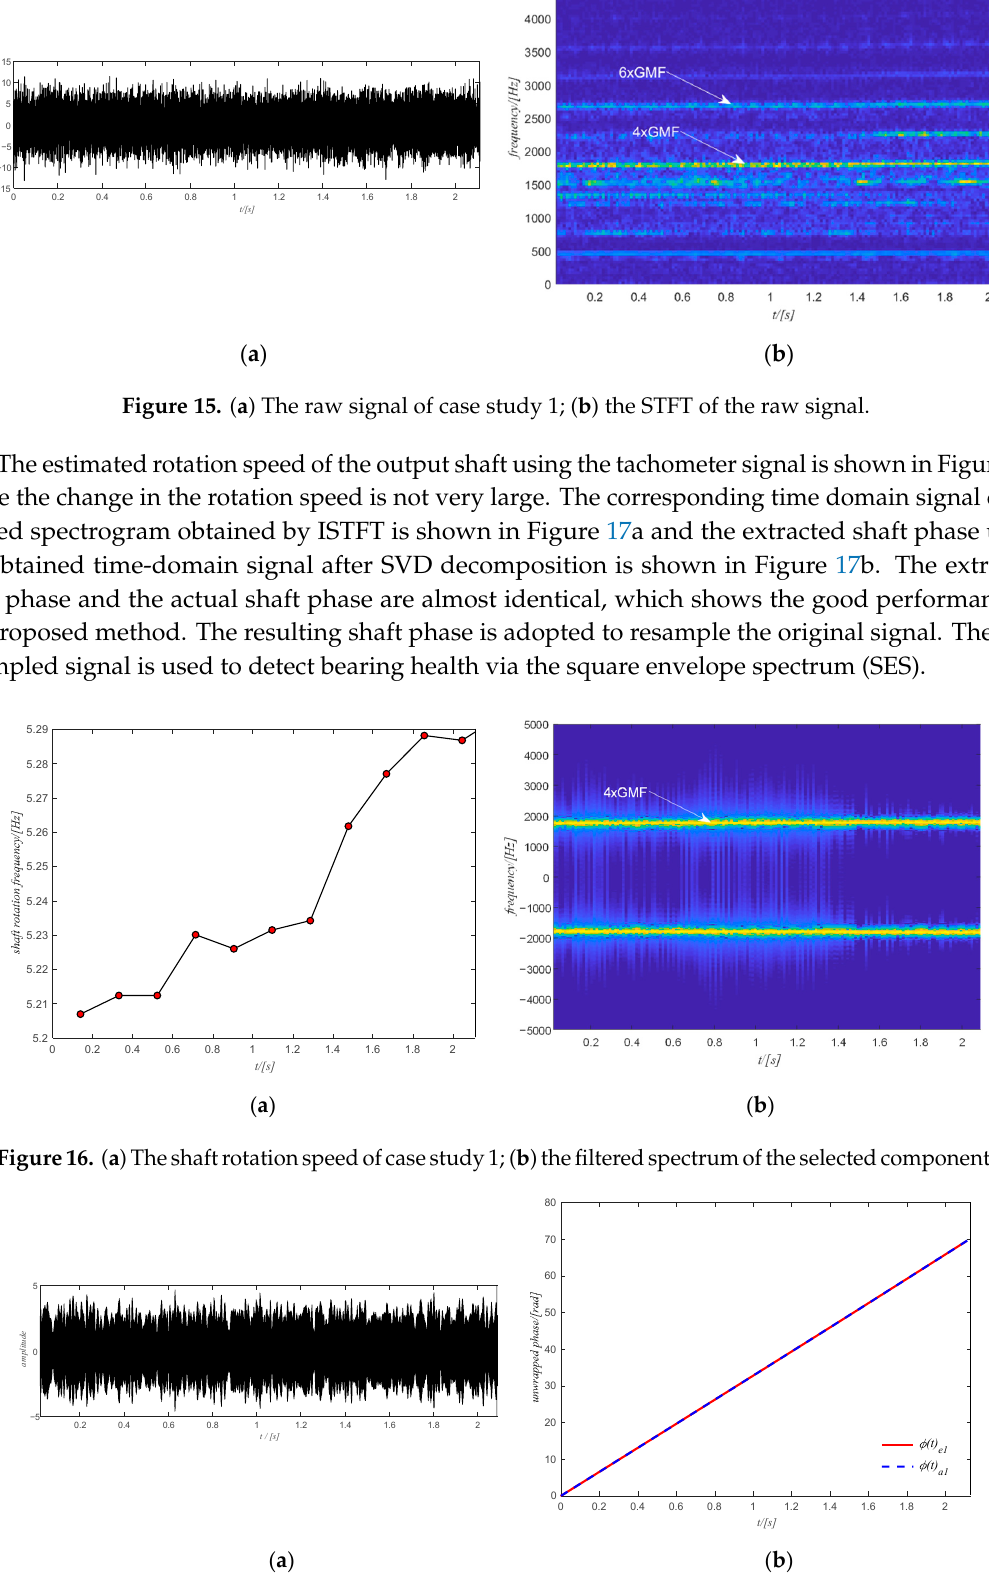
Figure 17. ( a ) time-domain signal of the filtered spectrum of case study 1; ( b ) final shaft phase using the time domain signal.